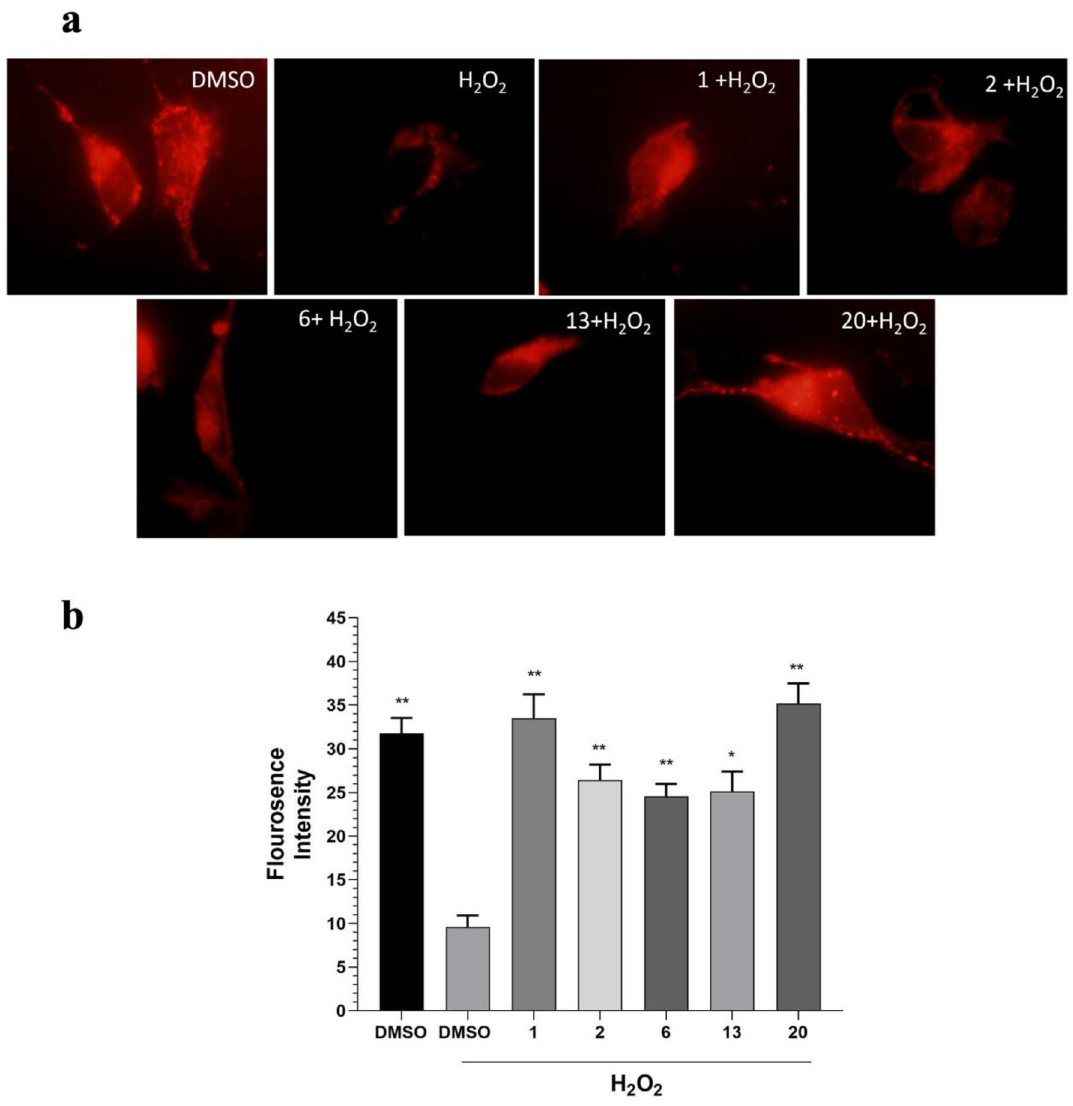
Figure 4. Selected metabolites protect SH-SY5Y cells from H 2 O 2 -induced mitochondrial damage. ( a ) Representative microscopy images of cells stained with MitoTracker Red. ( b ) Quantification of MitoTracker Red fluorescence intensities per cell volume (n = 30 cells). Data are presented as means ± S.E. (n =